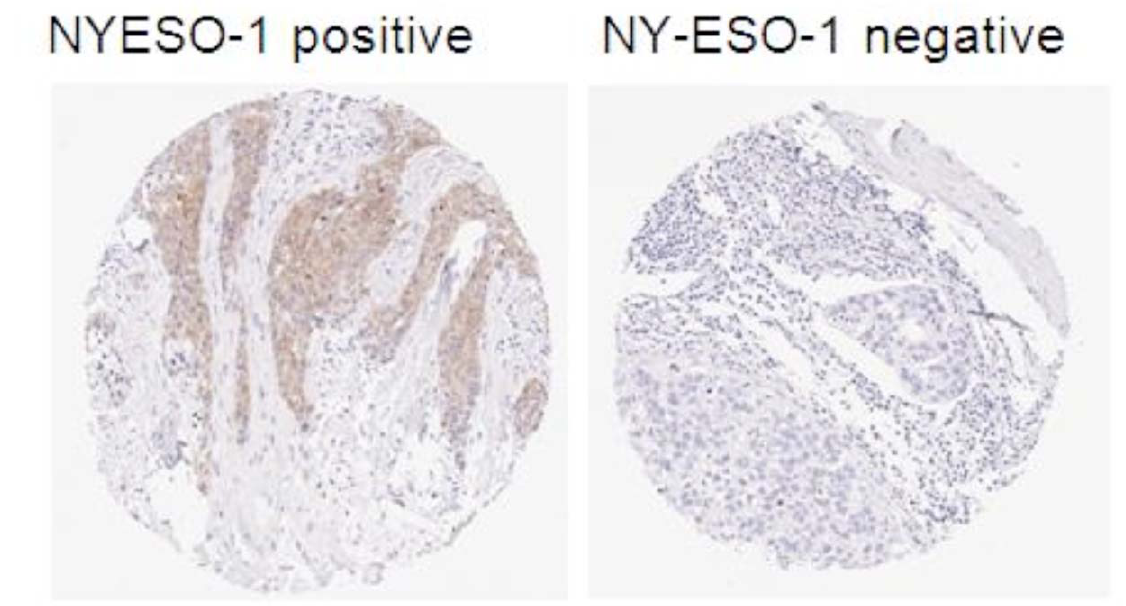
Figure 1. NY-ESO-1 expression by IHC compared with a negative IgG control. Photomicrograph of NY-ESO-1 expression by immunohistochemistry side by side compared with a negative IgG control.